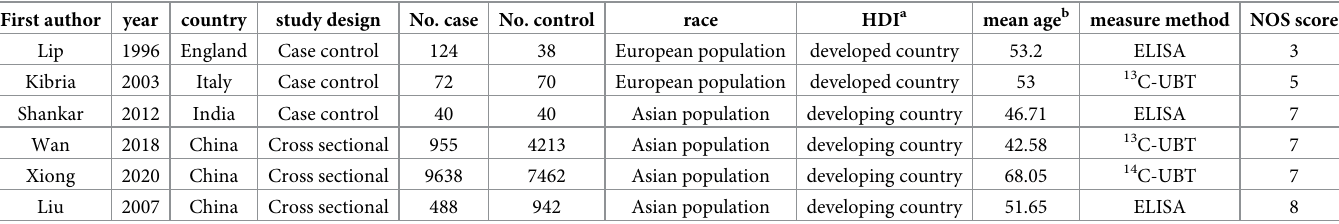
Table 1. Major characteristics of included